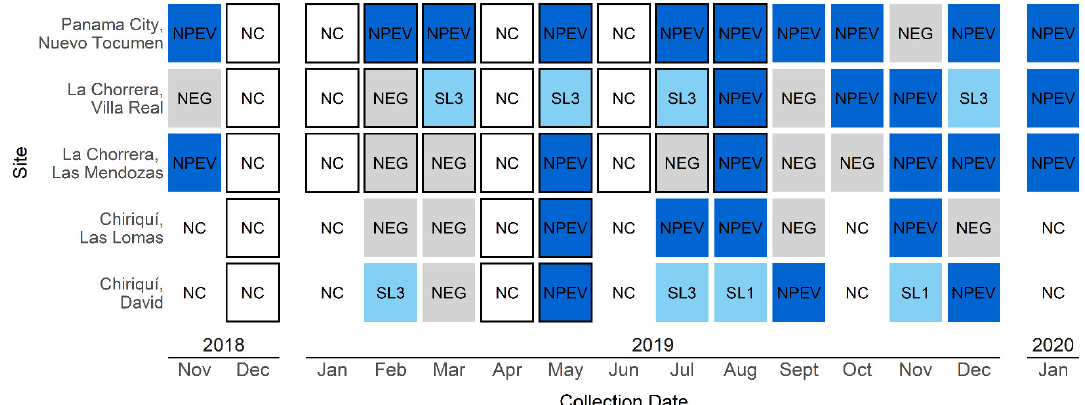
Figure 1. Detection of poliovirus and non-polio enteroviruses from sewage samples, by month and by site. Black outline indicates immunization for M5 ABGM trial . NC, no collection; NPEV, non-polio enterovirus; NEG, negative; SL3, Sabin-like type 3 poliovirus; SL1, Sabin-like type 1 polioviru s.